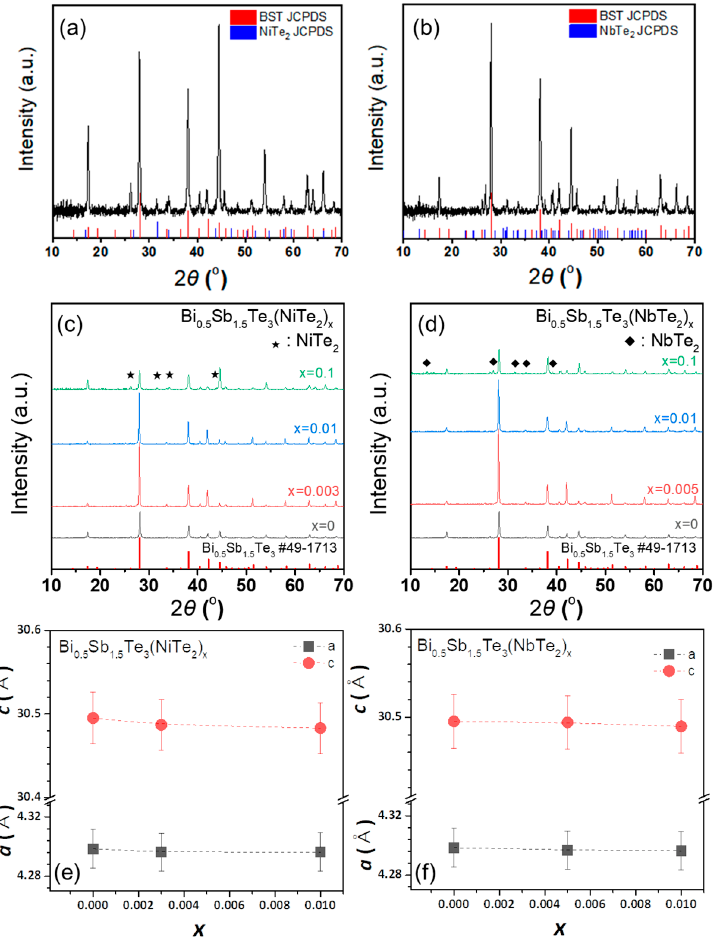
Figure 1. X-ray diffraction patterns for ( a , b ) melt-spun ribbons of ( a ) Bi 0.5 Sb 1.5 Te 3 (NiTe 2 ) x ( x = 0.1) and ( d ) Bi 0.5 Sb 1.5 Te 3 (NbTe 2 ) x ( x = 0.1)( c ) and ( c , d ) SPS-sintered pellet of Bi 0.5 Sb 1.5 Te 3 (NiTe 2 ) x ( x = 0, 0.003, 0.01, and 0.1) and ( d ) Bi 0.5 Sb 1.5 Te 3 (NbTe 2 ) x ( x = 0, 0.005, 0.01, and 0.1). Lattice parameters calculated for ( e ) SPS-sintered Bi 0.5 Sb 1.5 Te 3 (NiTe 2 ) x ( x = 0, 0.003, and 0.01) samples and ( f ) Bi 0.5 Sb 1.5 Te 3 (NbTe 2 ) x ( x = 0, 0.005, and 0.01).